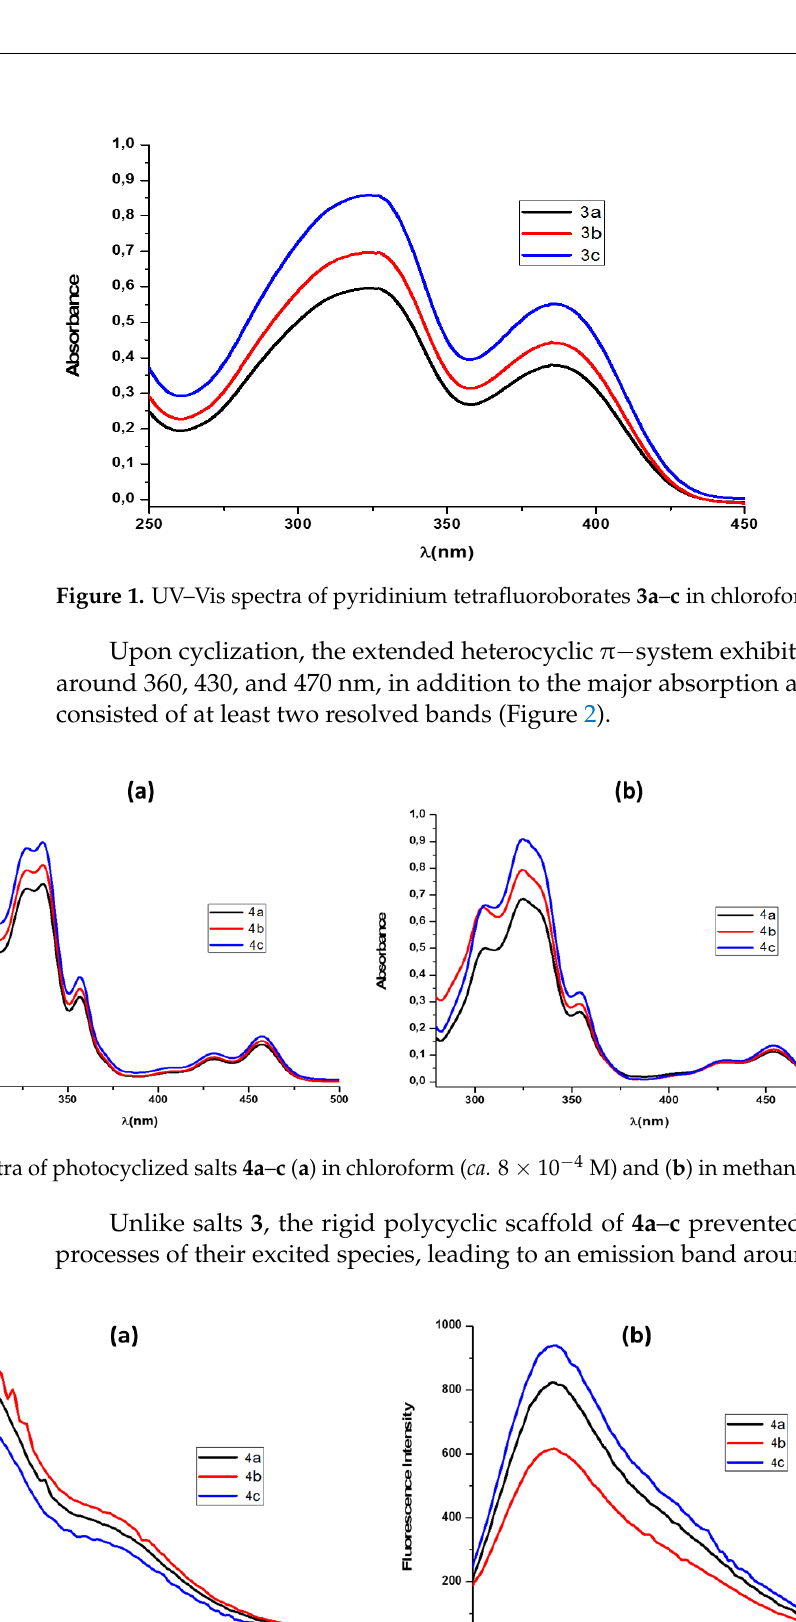
Figure 3. Fluorescence spectra of photocyclized salts 4a – c ( a ) in chloroform ( ca. 6 × 10 −6 M), upon excitation at λ maxexc = 350 nm; ( b ) in methanol ( ca. 8 × 10 −6 M), upon excitation at λ maxexc = 350 nm.